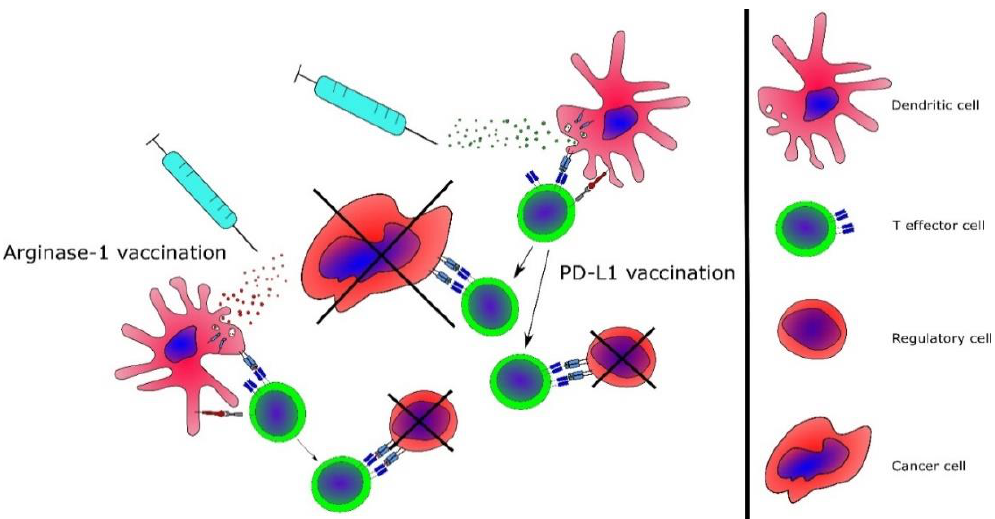
Figure 3. Therapeutic cancer vaccination targeting immunosuppressive mechanisms in MPN. Left. Vaccination with arginase-1 (ARG1)-derived epitopes will enhance the ARG1-specific T-cell response, leading to the recognition and killing of ARG1-producing cells and resulting in decreased amounts of ARG1 in the tumor microenvironment. Right. Vaccination with PD-L1-derived epitopes will induce a T-cell response against regulatory cells and against JAK2 V617F-mutant cells.